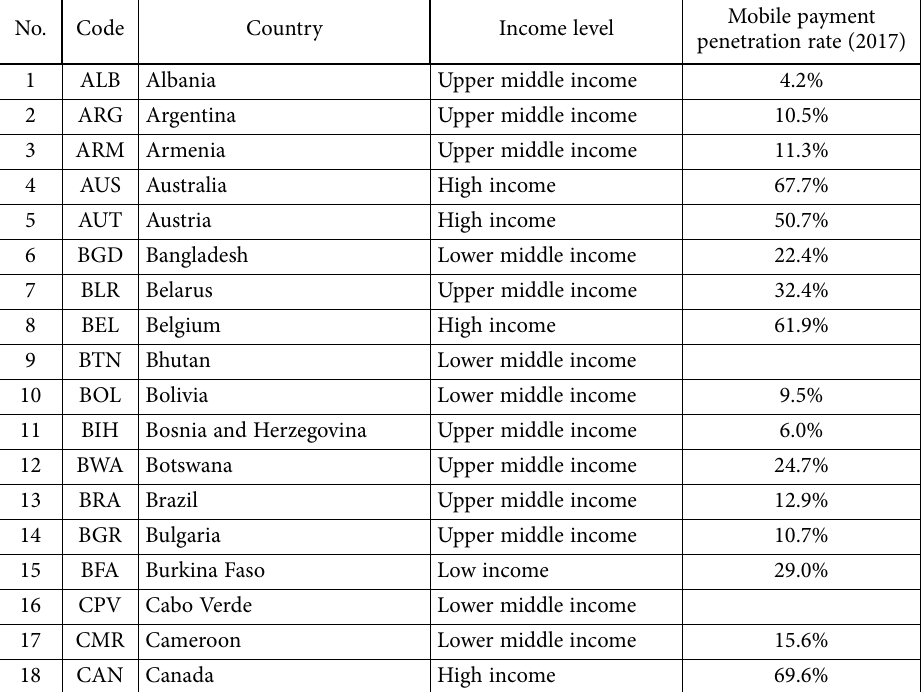
Table A1. List of sample countries